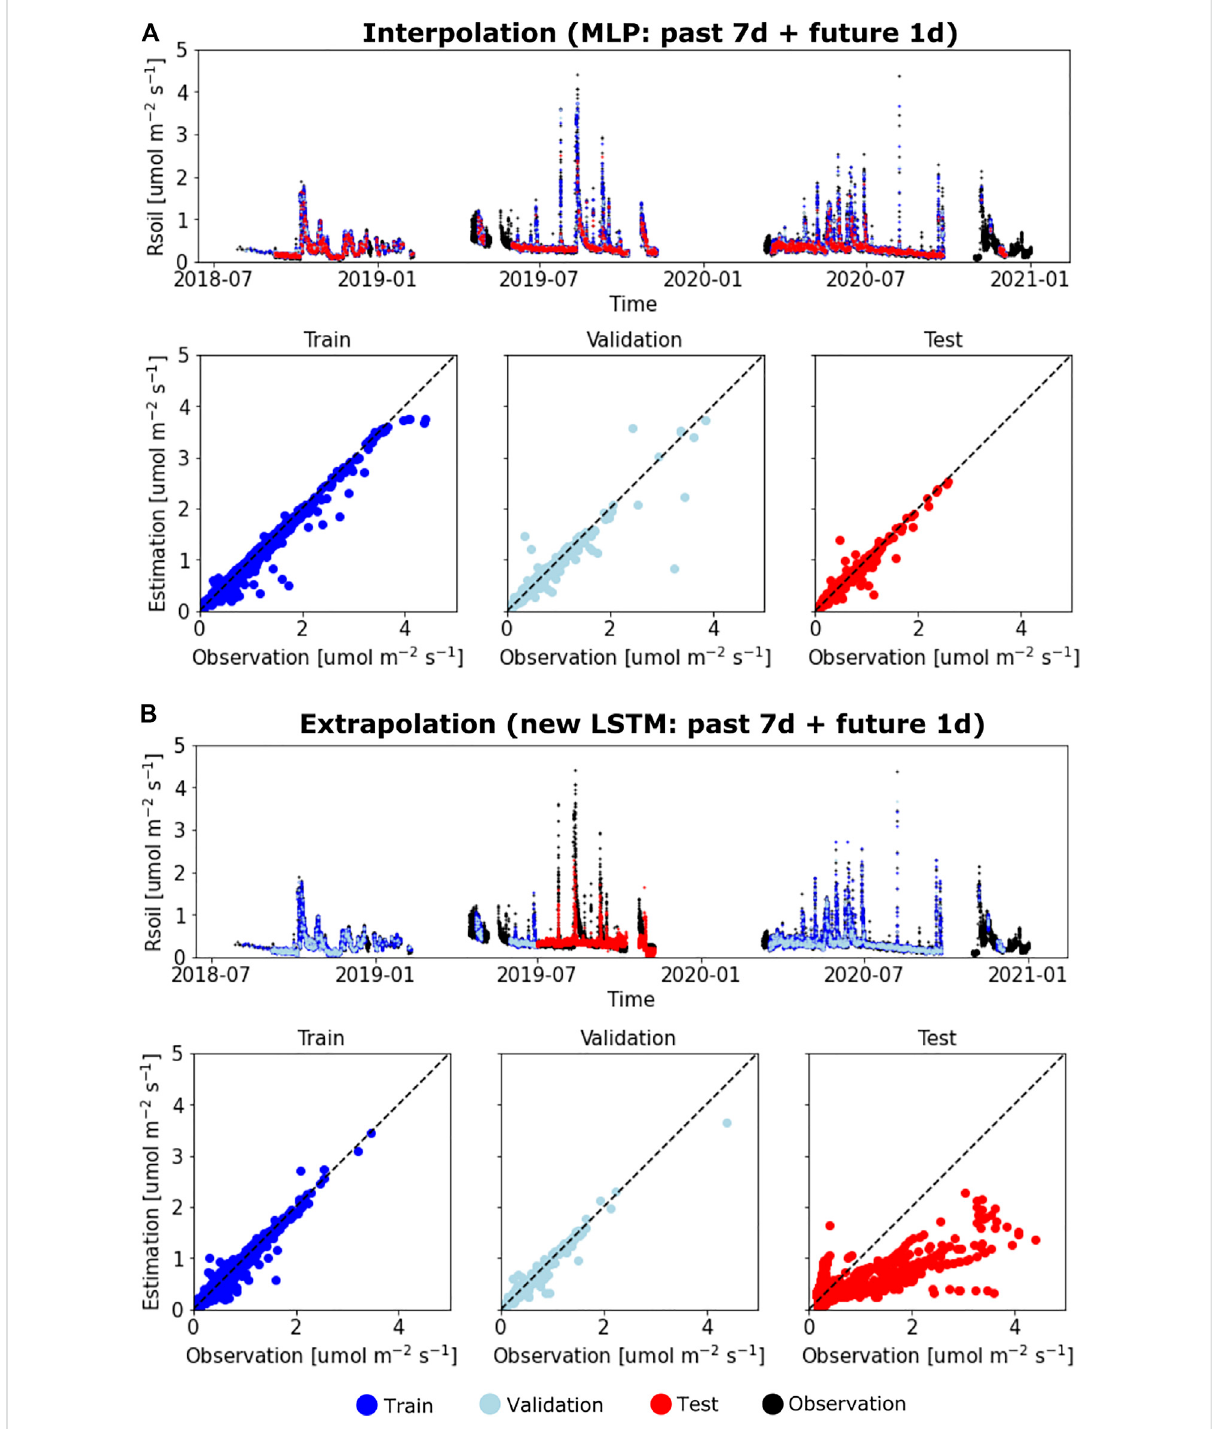
FIGURE 5 Comparisonbetweenthebestinterpolationandextrapolationmodels. (A) observedandestimatedRsoilfortraining,validation,andtestdatasets using the best interpolation model (i.e., MLP that takes the past 7 days of Tsoil/SWC/Precip and 24 future hours of Tsoil as inputs). (B) observed and estimated Rsoil for training, validation, and test datasets using the best extrapolation model (i.e., the new LSTM that takes the past 7 days of Tsoil/ SWC/Precip and the future 24 h of Tsoil as